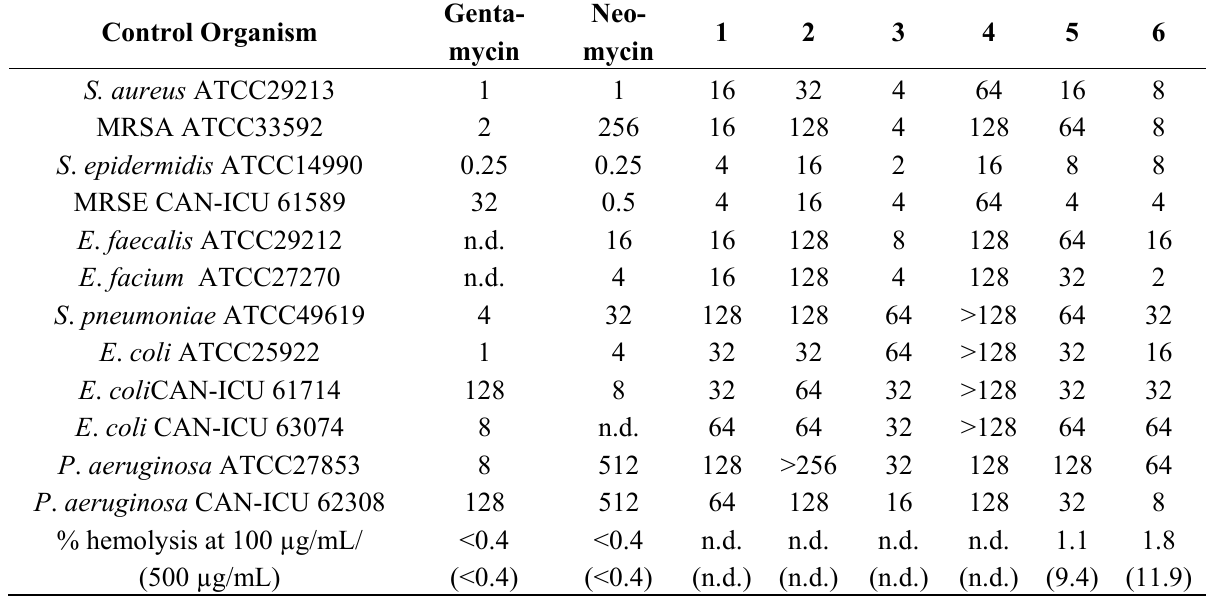
Table 1. Antibacterial and hemolytic activity (MIC) in µg/mL of various neomycin B-based mono- and bilipids 1 – 6